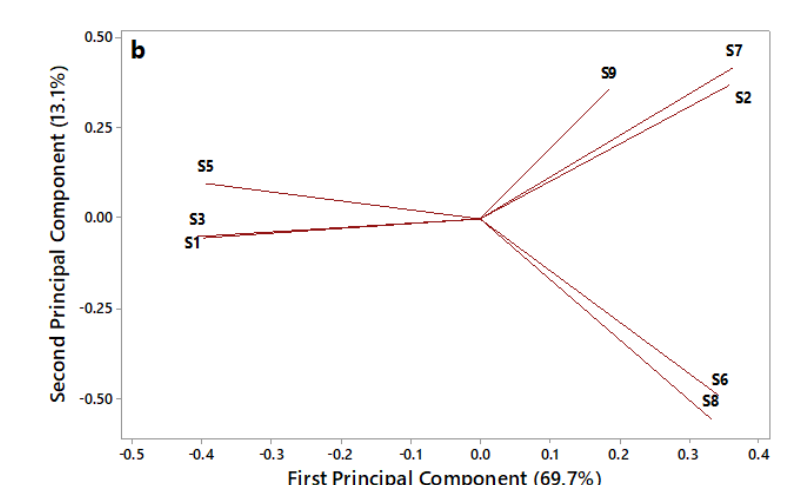
Figure 3. Principal Component Analysis(PCA) score plots ( a1 , a2 ) and loading plot ( b ) of electronic nose data collected on control (green), benign (yellow), and case (red) samples. In the score plot ( a1 ) empty symbols are for premenopausal (pre ‐ m) patients, and full symbols are for postmenopausal (post ‐ m) patients. In the score plot ( a2 ) empty black symbols are for early ‐ stage patients. Two score pots were elaborated to: i. discriminate premenopausal and postmenopausal patients (Figure 3a1). ii. evaluate the plot distribution for early ‐ stage ovarian cancer (OC) patients (Figure 3a2).